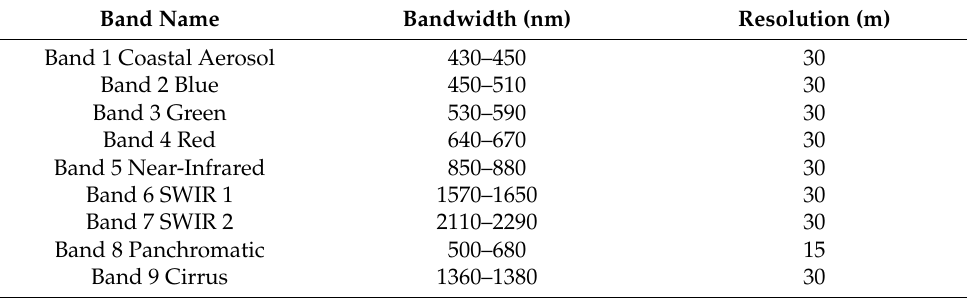
Figure 1. Location of the study area. ( A ) Landsat 8 OLI image of the study area is shown in true color; the lower figure shows a zoomed view of the region around San Dou Island, with ( A , B ) showing small- and large-scale rafts, respectively. The images on the right are zoomed views of the east side of Qingshan Island, with ( C , D ) showing the image before pansharpening and after pansharpening, respectively. Table 1. Landsat 8 OLI band